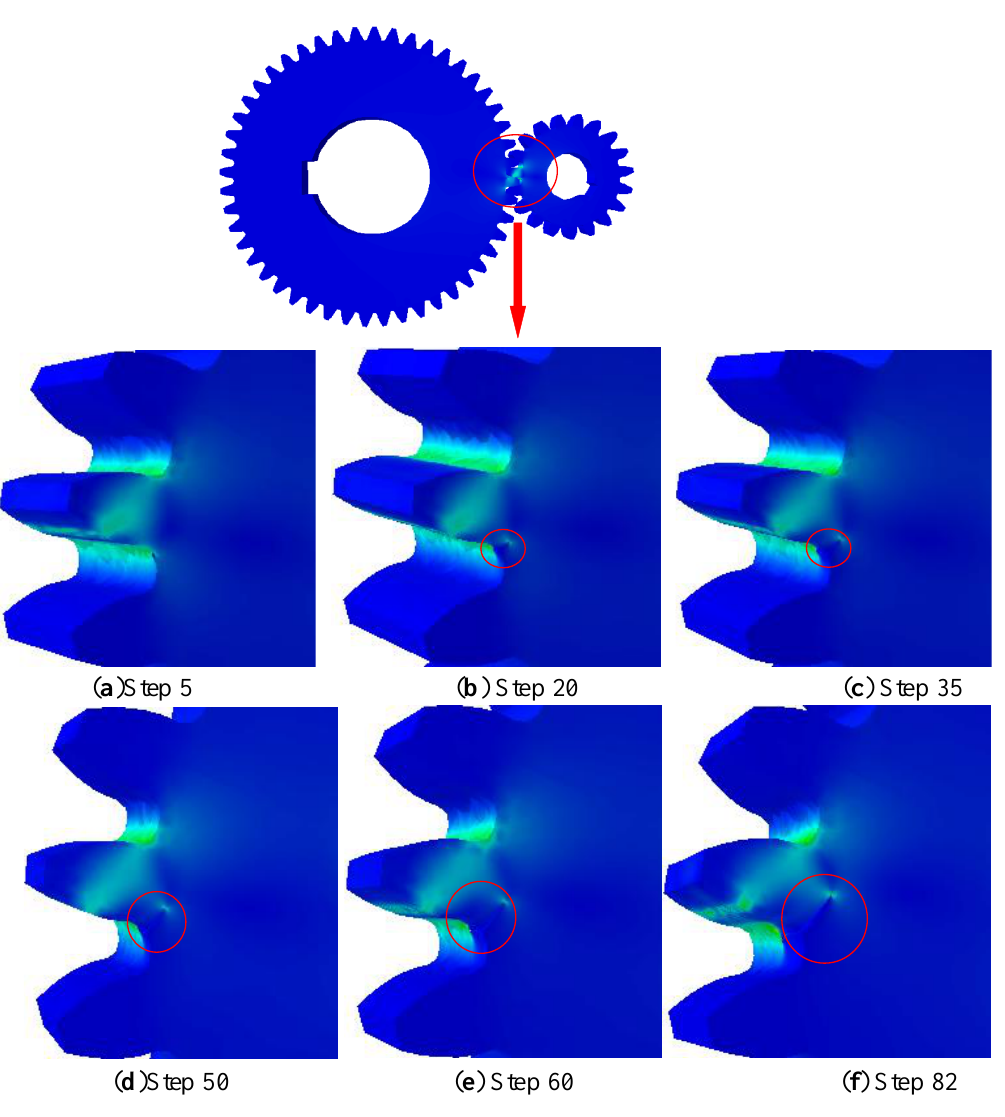
Figure 16. Simulation results of bending crack based on OSPD fatigue model. ( a ) Crack propagates under iterative step = 5; ( b ) crack propagates under iterative step = 20; ( c ) crack propagates under iterative step = 35; ( d ) crack propagates under iterative step = 50; ( e ) crack propagates under iterative step = 60; ( f ) crack propagates under iterative step = 82; The red circles in the figures indicate the crack length is gradually increasing.